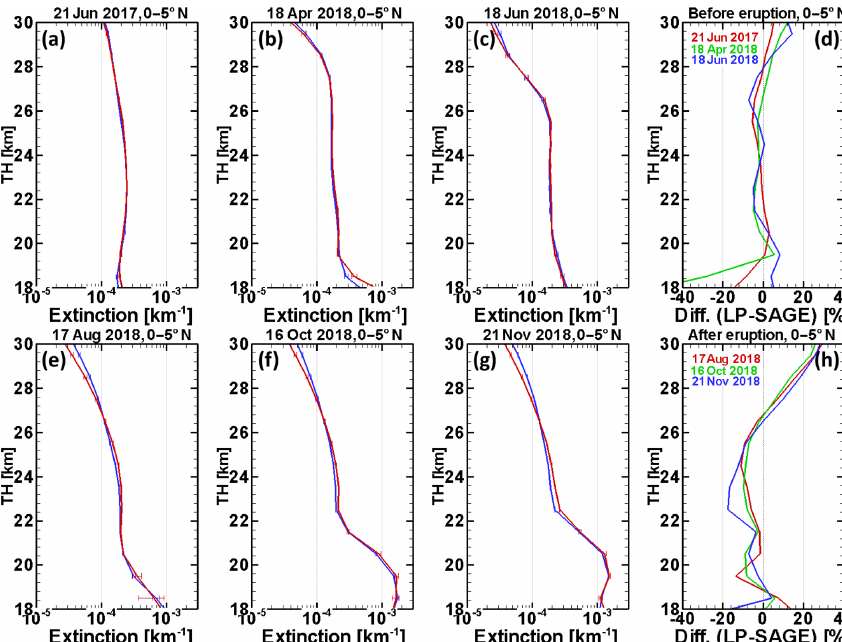
Figure 6. Comparison of daily zonal mean of OMPS/LP (blue) and SAGE III/ISS (red) aerosol extinction profiles in the 0–5 ◦ N latitude bin for 6 individual days prior to (a) – (c) and after (e) – (g) the Ambae eruption on 27 July 2018. The corresponding relative differences between LP and SAGE are also shown in panels (d) and (h) . The horizontal error bars on the mean extinction profiles indicate the standard error of the √ N . Enhanced extinction values around 20km after the eruption (e) – (g) are observed compared with before the eruption (a) – (c) mean, σ/